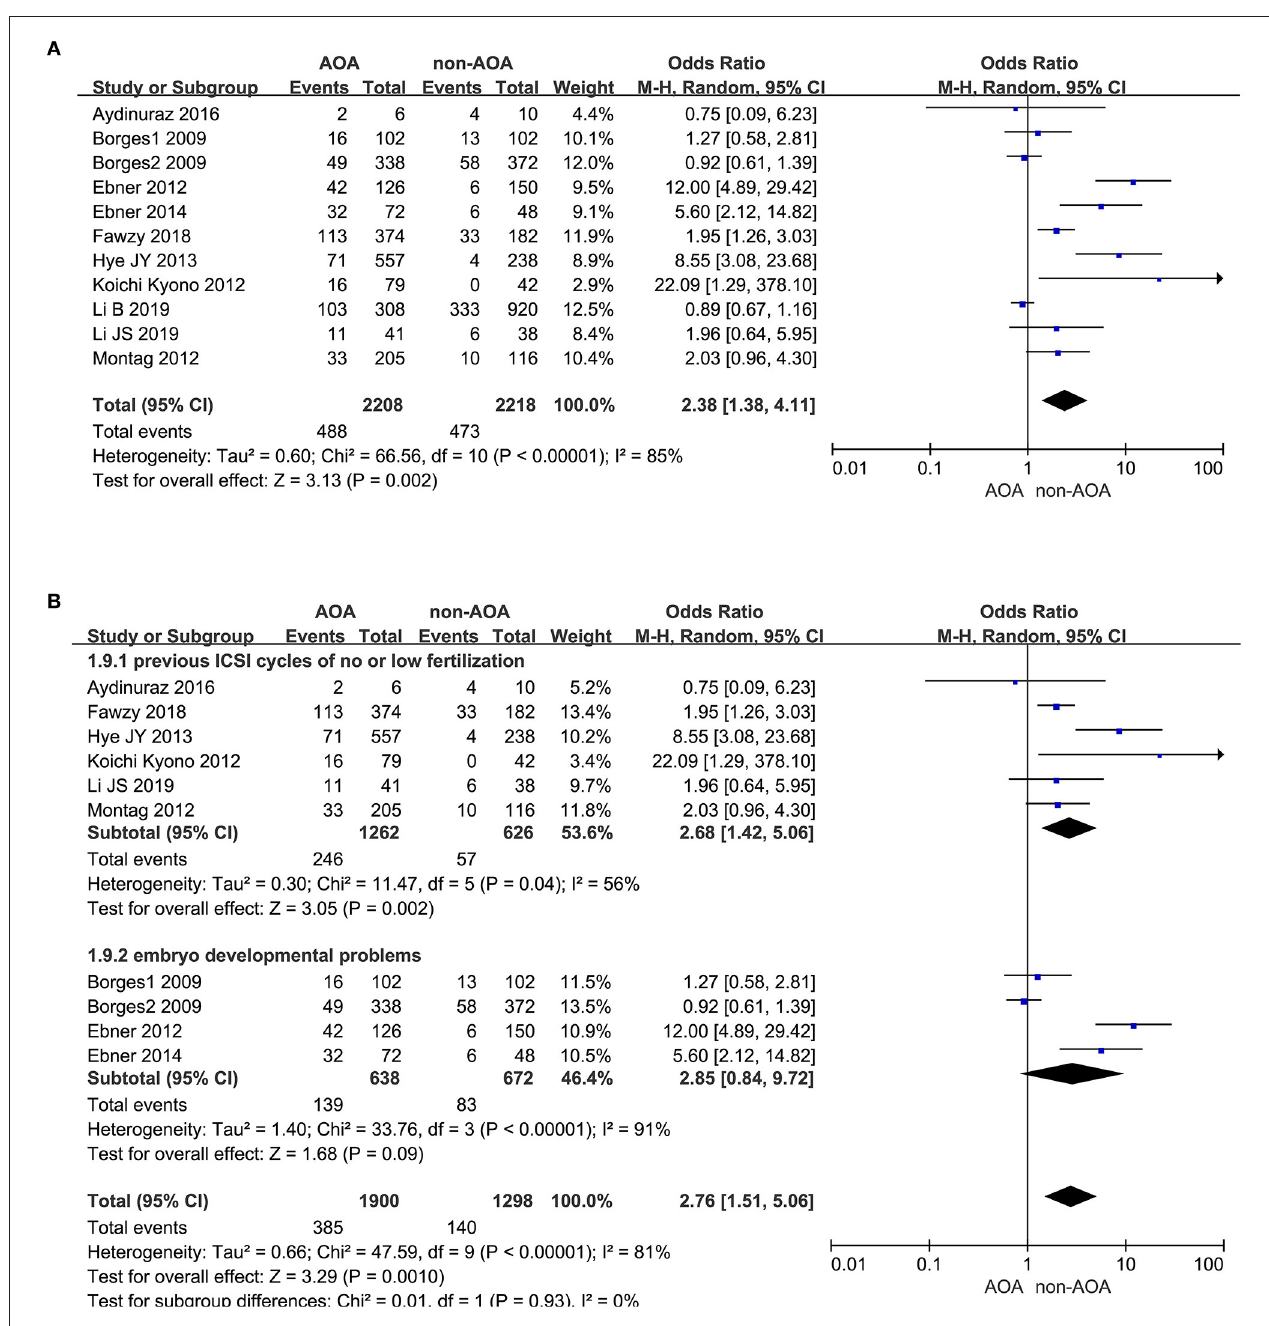
FIGURE 8 | (A) Forest plot of implantation rate between AOA treatment and non-AOA treatment patient groups using calcium ionophore. (B) The subgroup analysis of implantation rate between AOA treatment and non-AOA treatment patient groups.